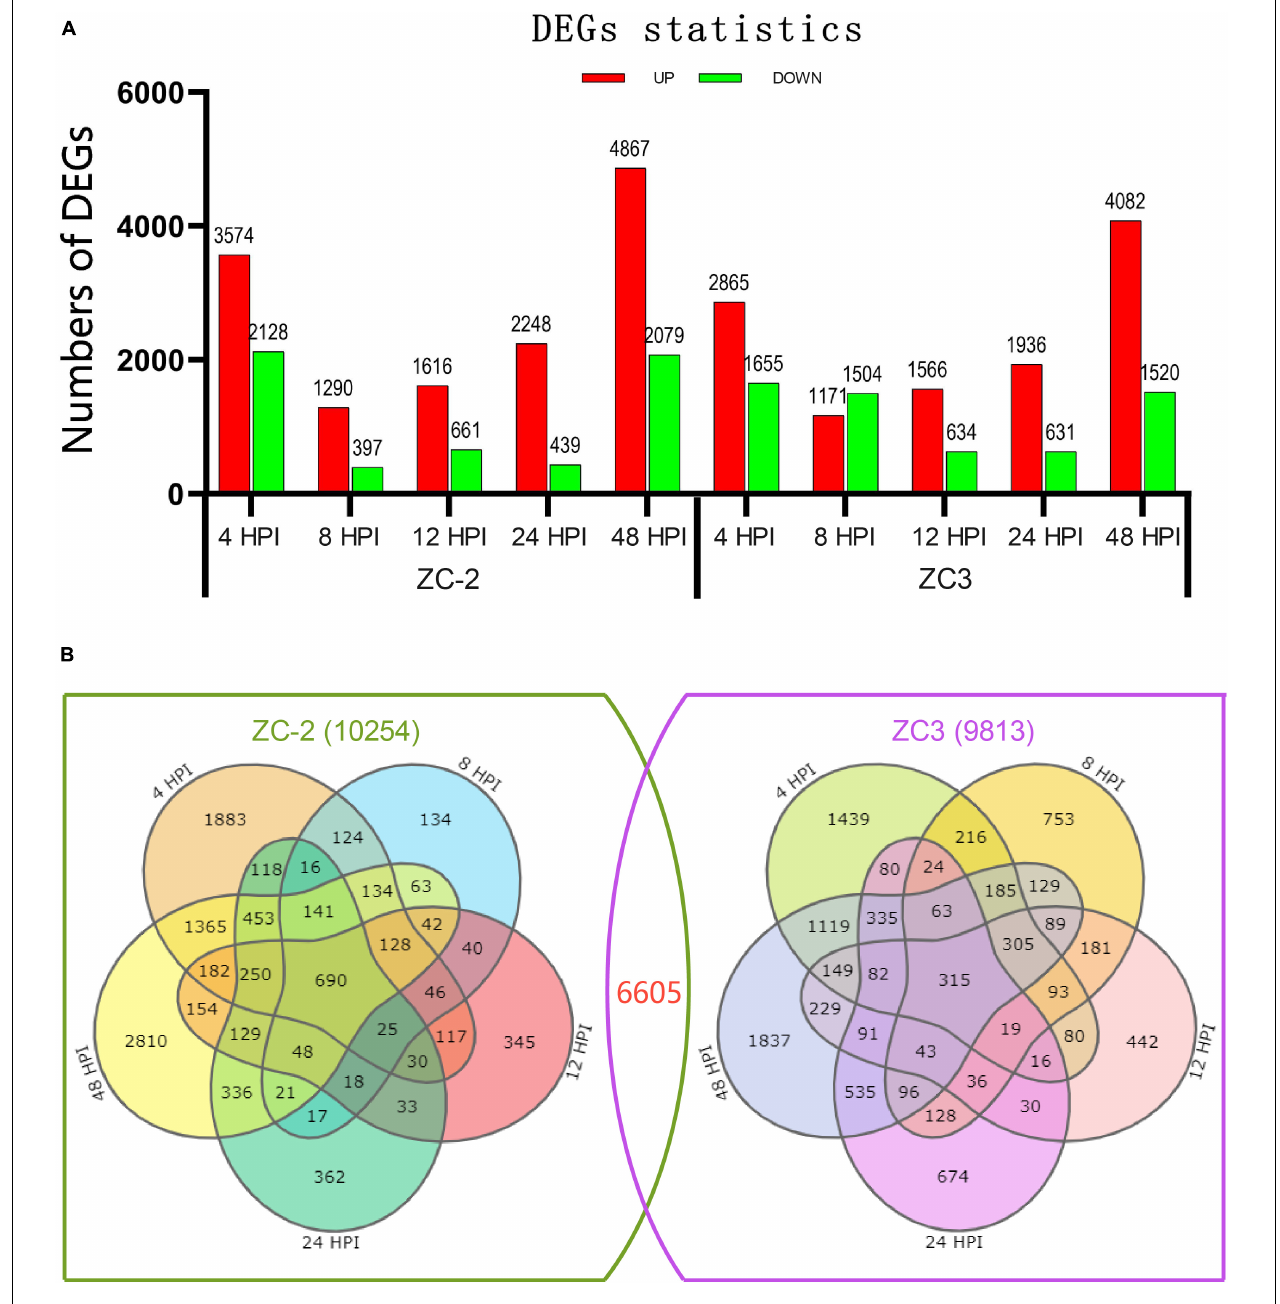
FIGURE 3 | (A) Number of significantly differentially expressed genes (DEGs) detected from pods of soybean lines ZC-2 and ZC3 infected with Colletotrichum truncatum . The transcriptome was sampled at five time points after inoculation. The DEGs are shown in red (up-regulated) or green (down-regulated). (B) Venn diagram of the DEGs for each